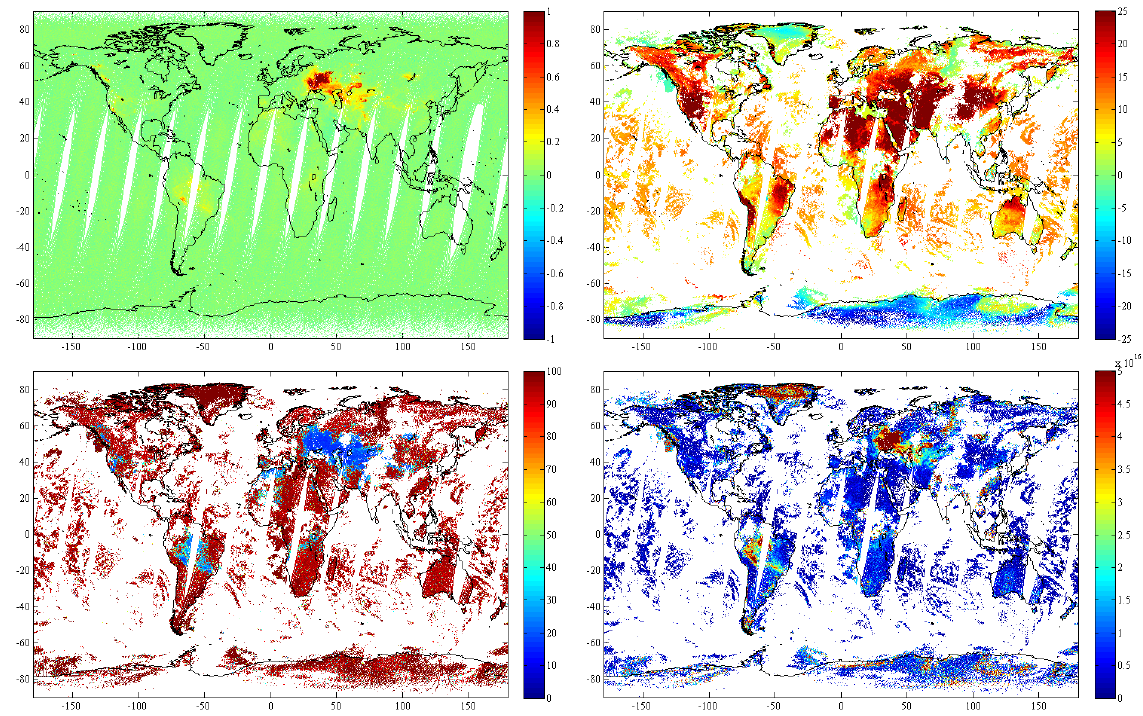
Fig. 6. From top to bottom and from left to right: HRI (no unit), thermal contrast (K), relative error (%) and NH 3 total columns (moleccm − 2 ) with posterior filtering, for 15 August 2010 in the morning, as in Fig. 2. The filtering applied here (apart from the HRI) removes all points with a cloud fraction above 25% and a surface temperature below